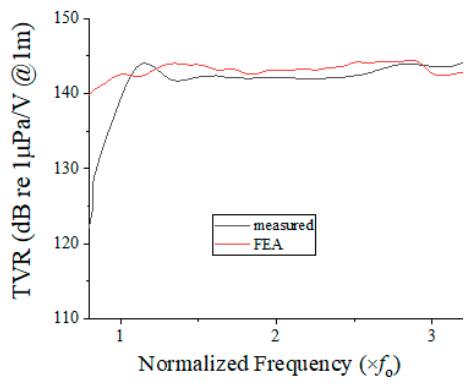
Figure 12. TVR spectra of the potted array.